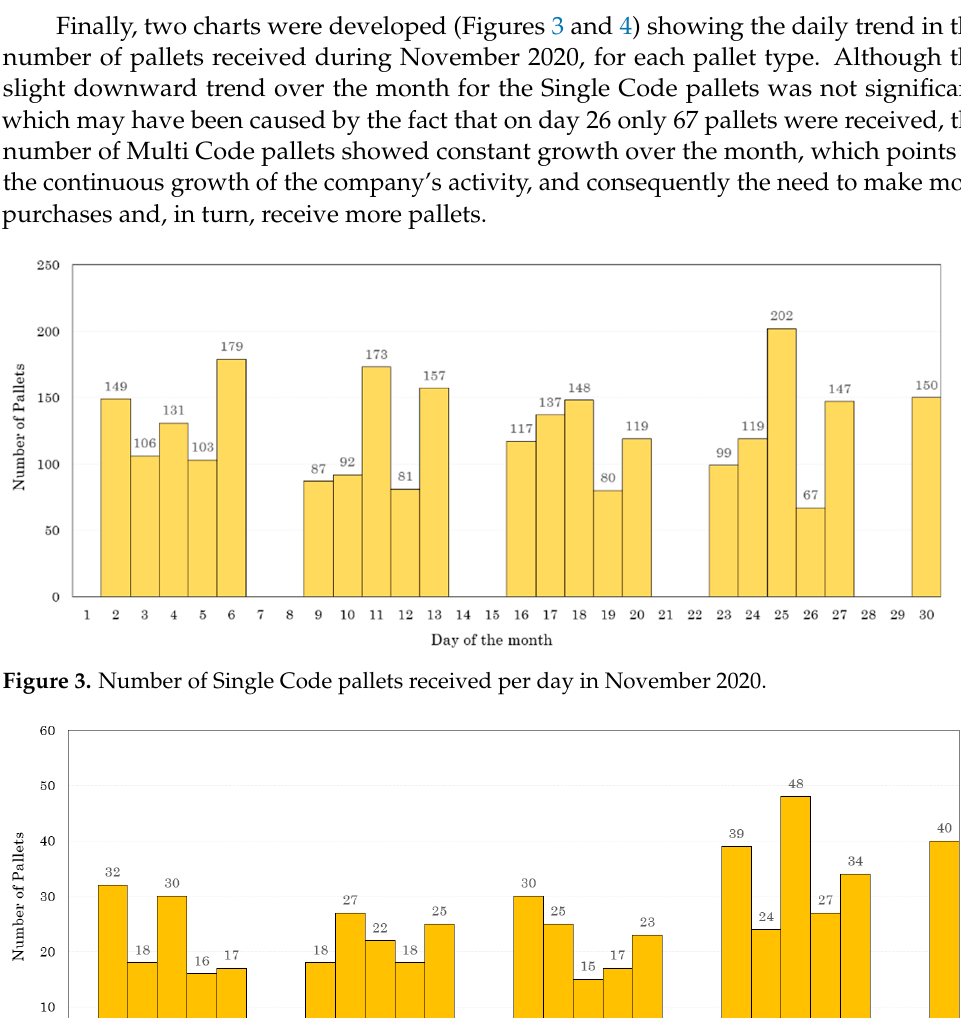
Figure 5. Time (in minutes) spent processing each type of pallet in November 2020. Figure 6. Percentage of time spent processing each type of pallet.